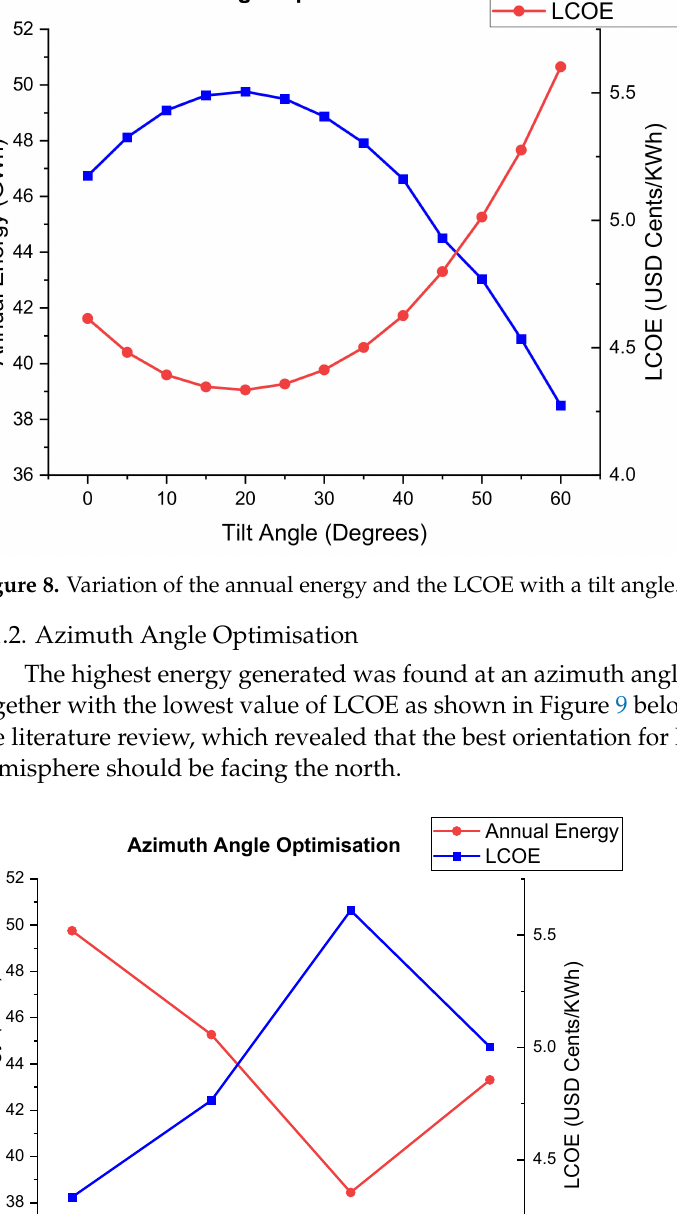
Figure 9. Variation of the annual energy and the LCOE with an azimuth angle.